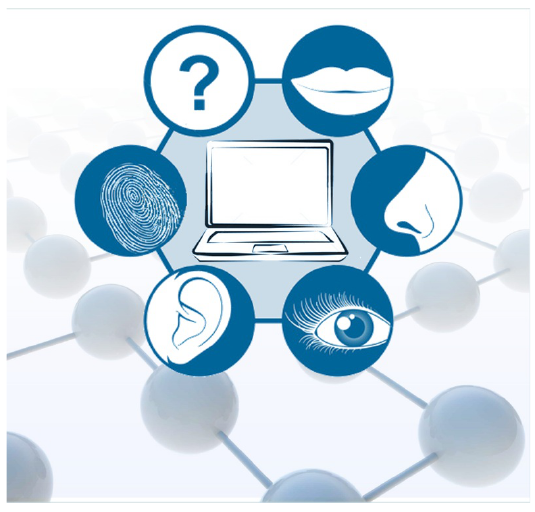
Figure 1. Sensing principles inspired in animal senses and/or networking are revolutionizing performance and scope of application of sensor